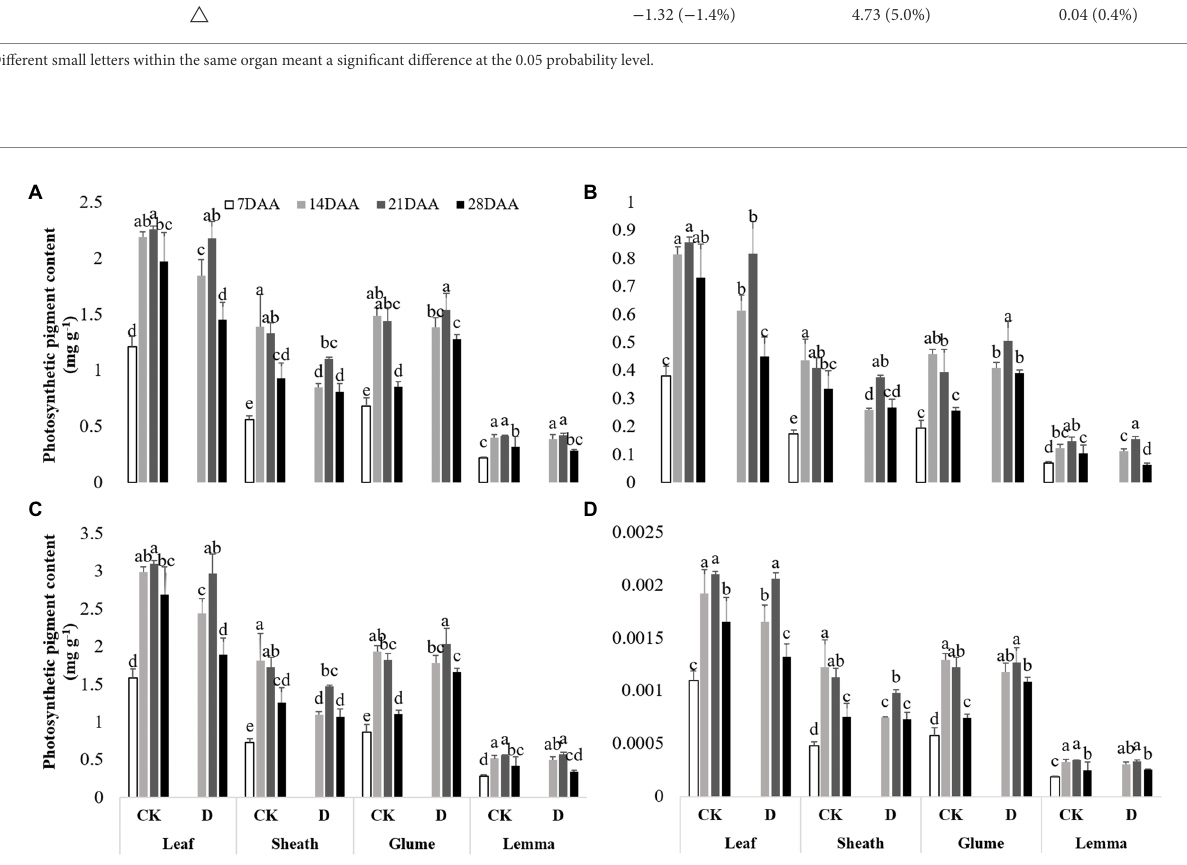
FIGURE 2 Photosynthetic pigment contents in the flag leaf, the sheath, the glume and the lemma under drought stress. (A) , chlorophyll a content (chla), (B) , chlorophyll b content (chlb), (C) , total chlorophyll content (total chl), (D) , xanthophyll content (xan). Different small letters within the same organ meant a significant difference at the 0.05 probability level.